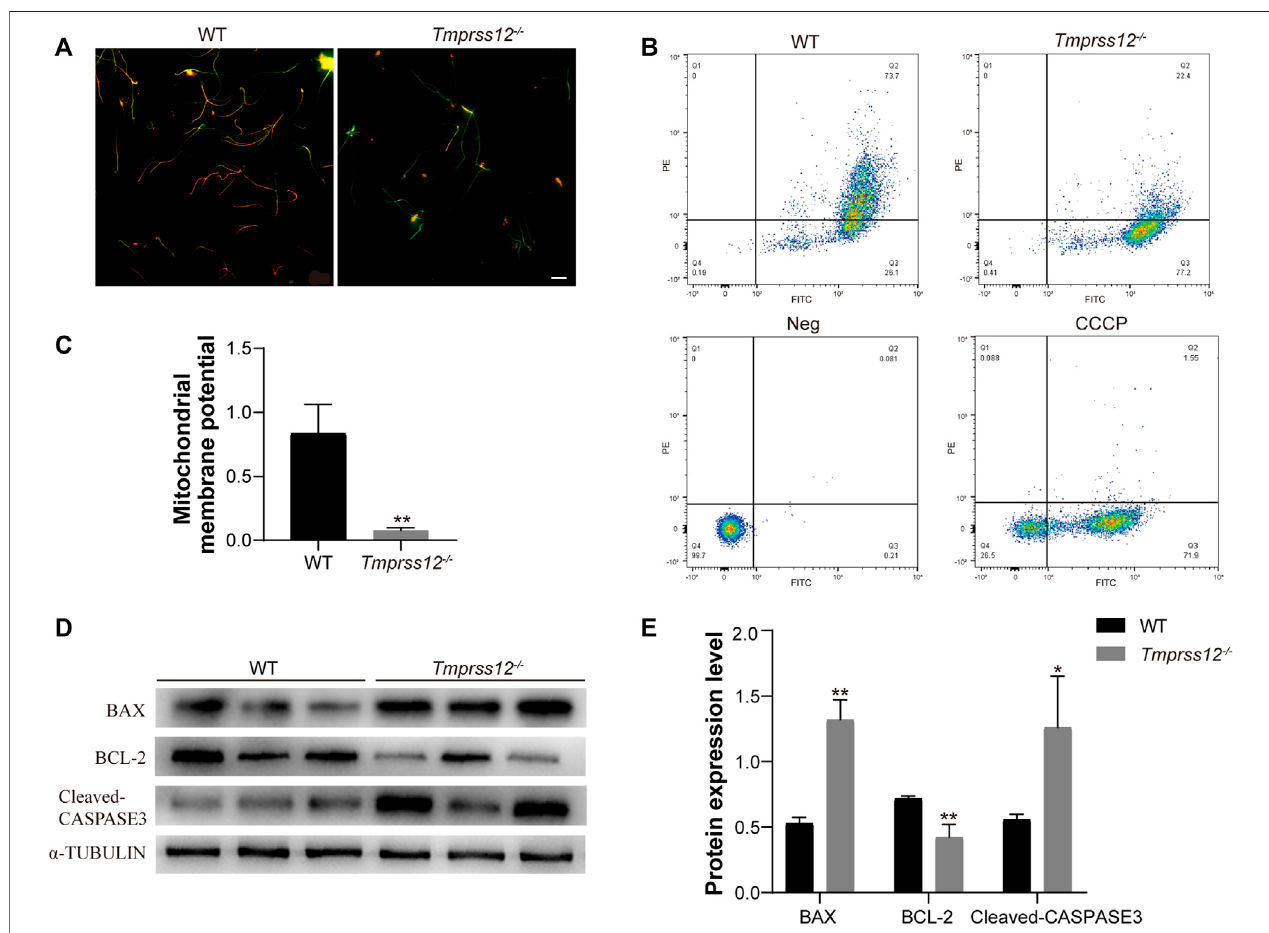
FIGURE 5 | Tmprss12 deletion causes increased sperm apoptosis. (A) Fluorescence microscopy observation of sperm after JC-1 staining between WT and Tmprss12 − / − mice. The red fl uorescent sperm were normal, and the green sperm had a low mitochondrial membrane potential (MMP). Scale bars: 20 µm. (B) Sperm from WT and Tmprss12 − / − mice stained with JC-1 dye were checked for their corresponding MMP through fl ow cytometry analysis. Q2, red-stain sperm; Q3, green- stain sperm. Neg and carbonyl cyanide 3-chlorophenylhydrazone (CCCP) were used as a negative control and positive control, respectively. (C) MMP was analysedbytherelativeratioofred/green fl uorescence.Thespermof Tmprss12 − / − miceshowedlowMMPlevels( n =3).Dataarethemean±s.d. p p < 0.05. (D) Western blot of apoptosis-related molecules from sperm of WT and Tmprss12 − / − mice. α -TUBULIN was used as an internal control. (E) Grey intensity analysis showing the expression level of the above markers. The expression levels of BAX and CASPASE3 were increased while BCL-2 was decreased in Tmprss12 − / − mice ( n = 3). Data are the mean ± s.d. p p <